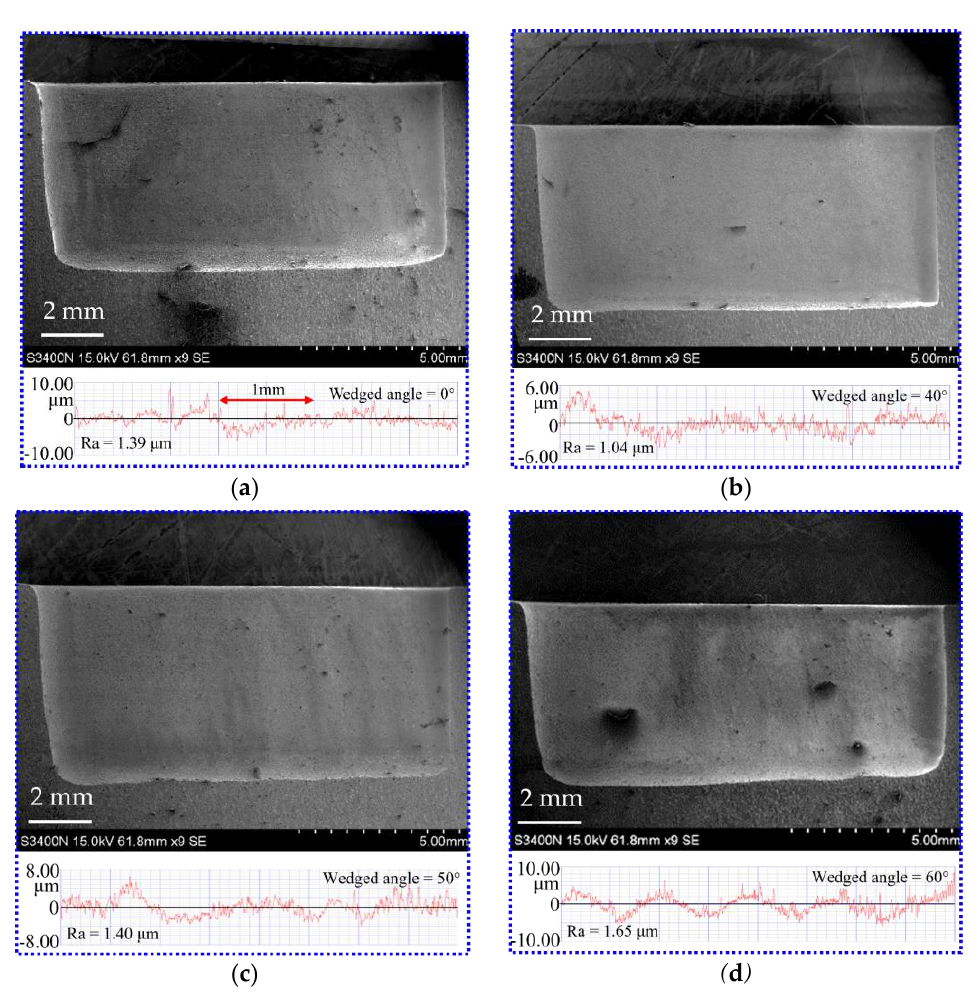
Figure 11. The SEM and surface roughness of sidewall of DNGs generated with different wedge angles in the end face of the tube tool: ( a ) wedged angle = 0°; ( b ) wedged angle = 40°; ( c ) wedged angle = 50°; and ( d ) wedged angle = 60°.